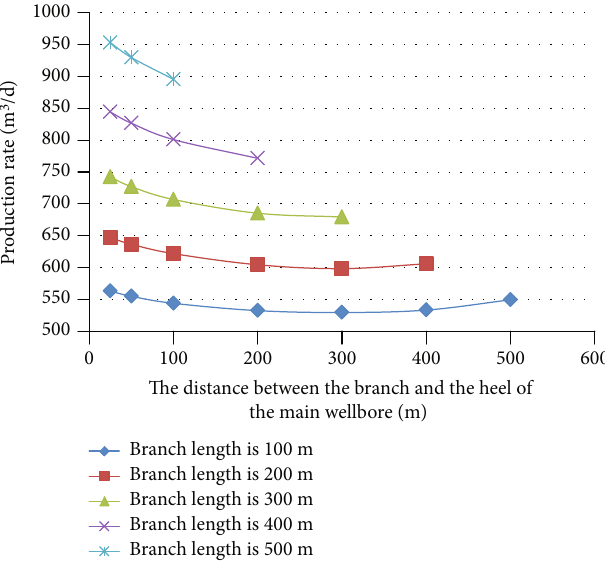
Figure 10: Production rates with di ff erent branch